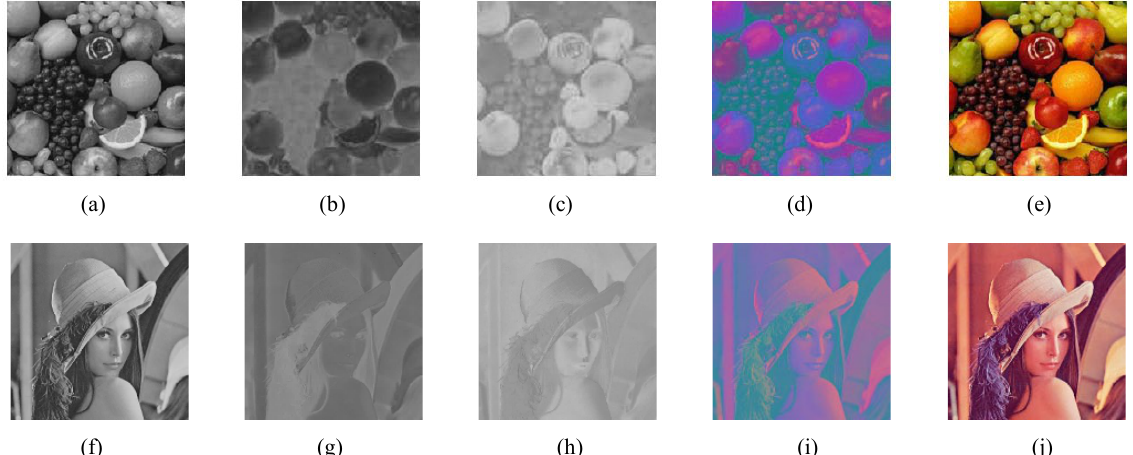
Fig. 4 Results of two images decompressed using the proposed compression algorithm: (a) – (c) decompressed Y, C b , and C r components of the “Fruit” image, respectively, (d) the color “Fruit” image reconstructed after decompression in the YC b C r color space, (e) the color “Fruit” image reconstructed after decompression in the RGB color space, and (f) – (j) corresponding to the results of (a) – (e) for “Lena” images, respectively.